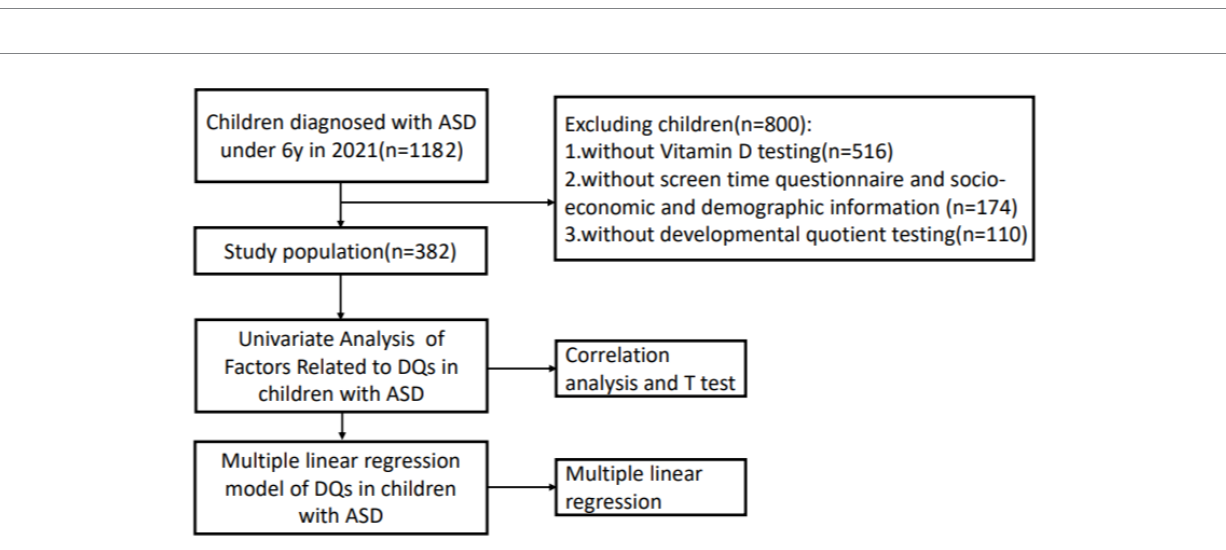
FIGURE 2 Schematic figure of the study